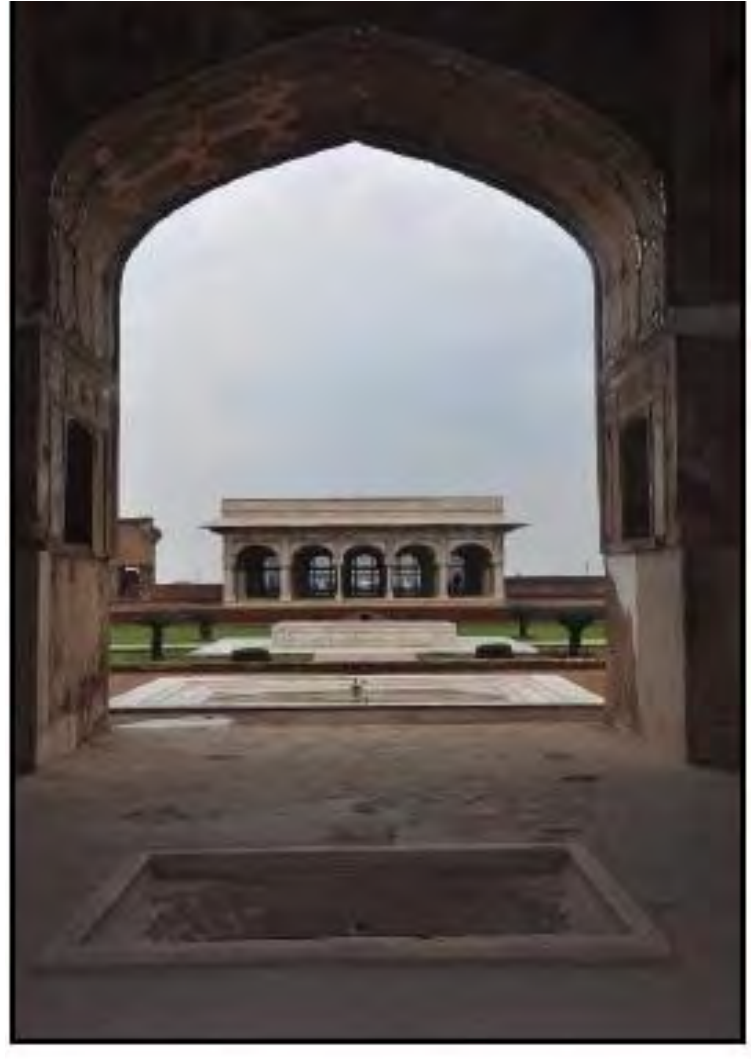
Figure 12. Fountain inside Khwab gah e Shah Jahani